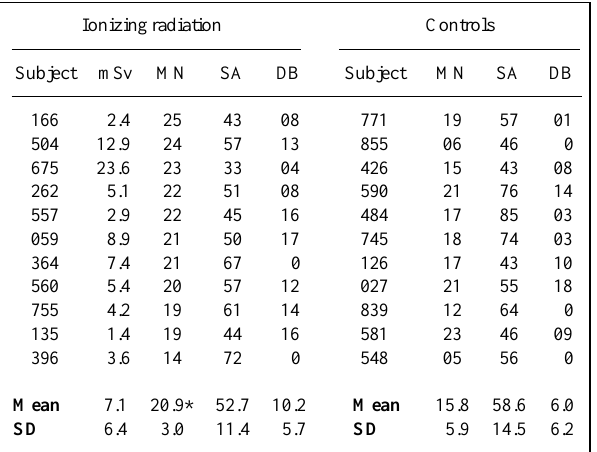
Table III - Frequency of binucleated cells with micronuclei (MN) and other nuclear anomalies in 2000 cells analyzed per hospital worker potentially exposed to ionizing radiation, and their respective